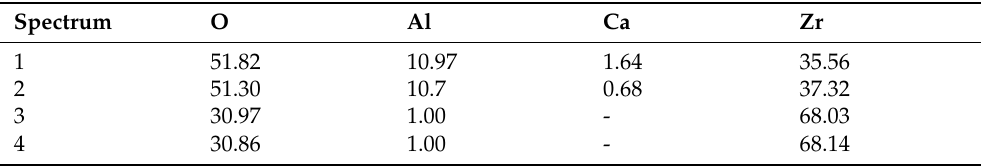
Figure 5. SEM micrograph of the ceramic membrane after UF. Table 4. SEM analyses after UF.